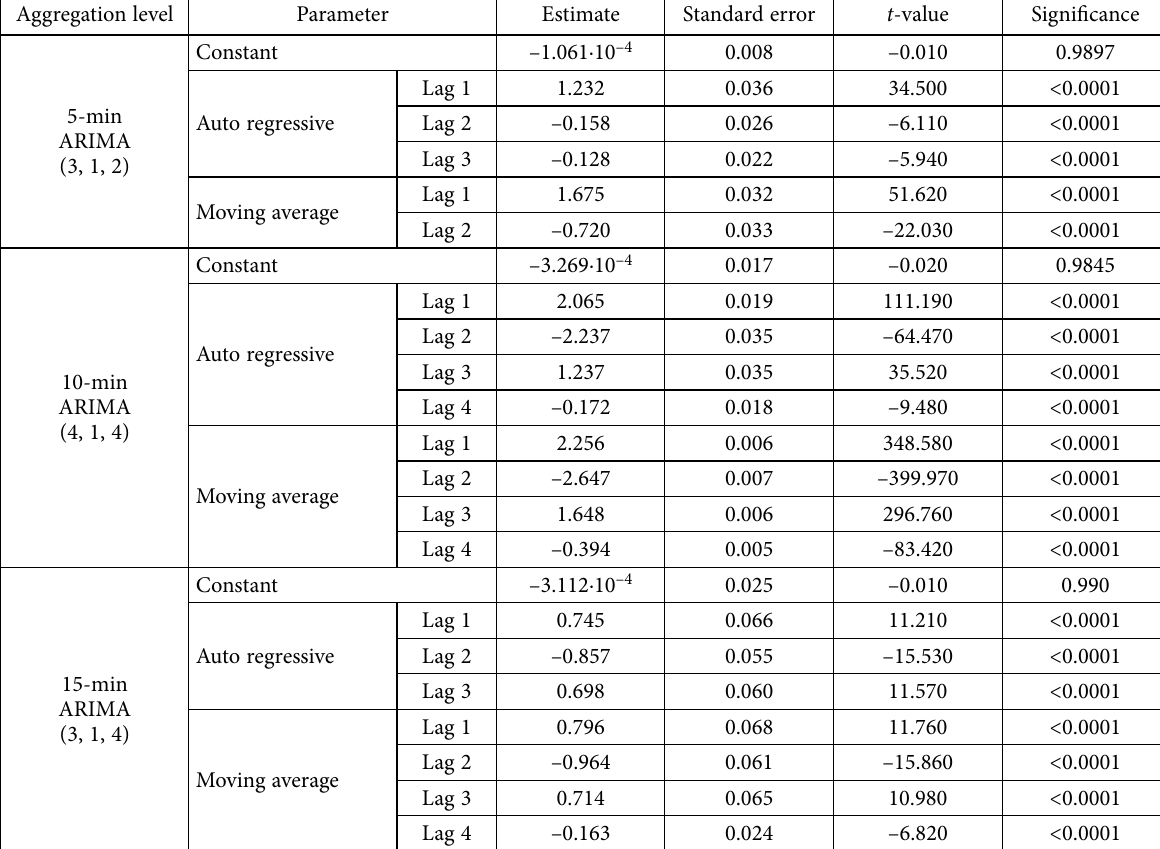
Fig. 5. The graphical check of residuals from the developed ARIMA model for 5-min traffic data at Site A Table 3. Estimation results of the ARIMA models for different aggregation intervals at Site